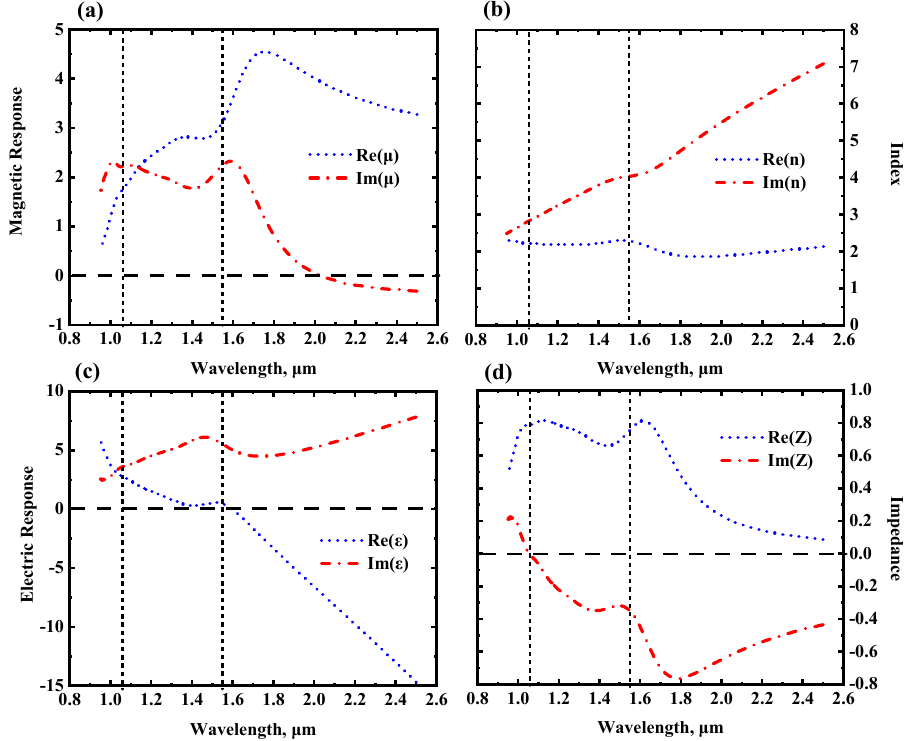
Figure 4. Effective optical constants of the metasurface. ( a ) Magnetic permeability. ( b ) Refractive index. ( c ) Permittivity. ( d ) Impedance. Please note that ‘Re’ represents the real part and ‘Im’ represents the imaginary part.